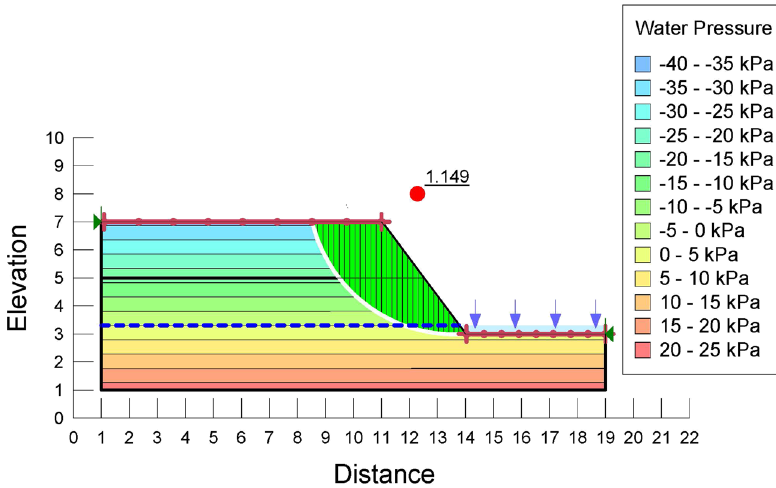
Figure 9: Slope stability for one cycle of applying rationing system.